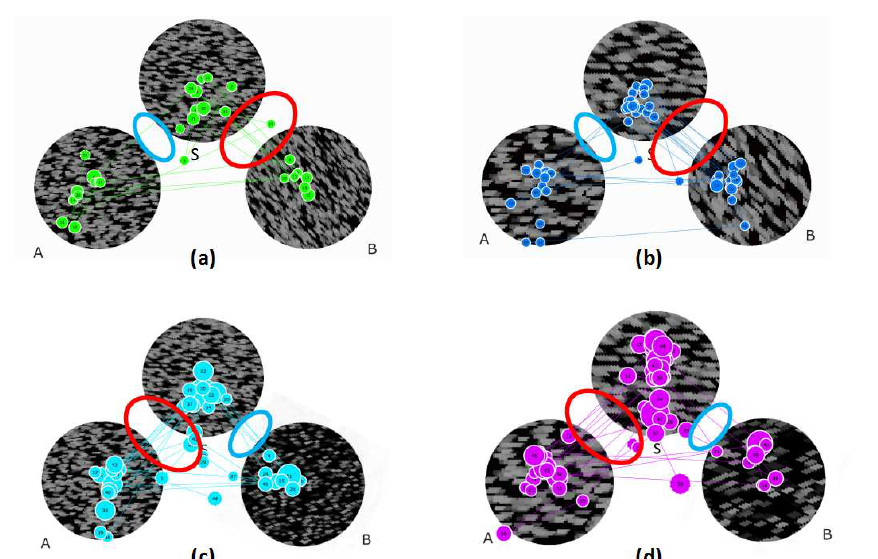
Figure 6. Examples of fixation-transfer counts (FTCs) for four scenes. ( a ) Scene 1: FTCs in the red circle on the right were greater than those in the blue circle on the left; the final similarity choice was Texture B. ( b ) Scene 2: FTCs in the red circle on the right were greater than those in the blue circle on the left; the final similarity choice was Texture B. ( c ) Scene 3: FTCs in the blue circle on the right were less than those in the red circle on the left; the final similarity choice was Texture A. ( d ) Scene 4: FTCs in the blue circle on the right were less than those in the red circle on the left; the final similarity choice was Texture